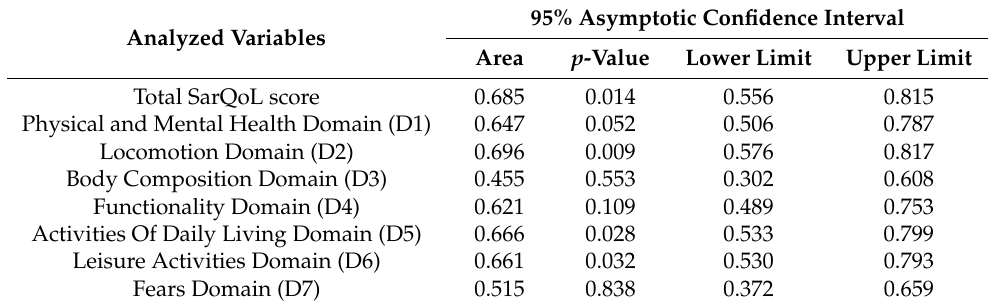
Table 5. ROC curves diagnostic performance values for each domain and total score of SarQoL ques- tionnaire when it was used to discriminate sarcopenic pathology (only confirmed and severe